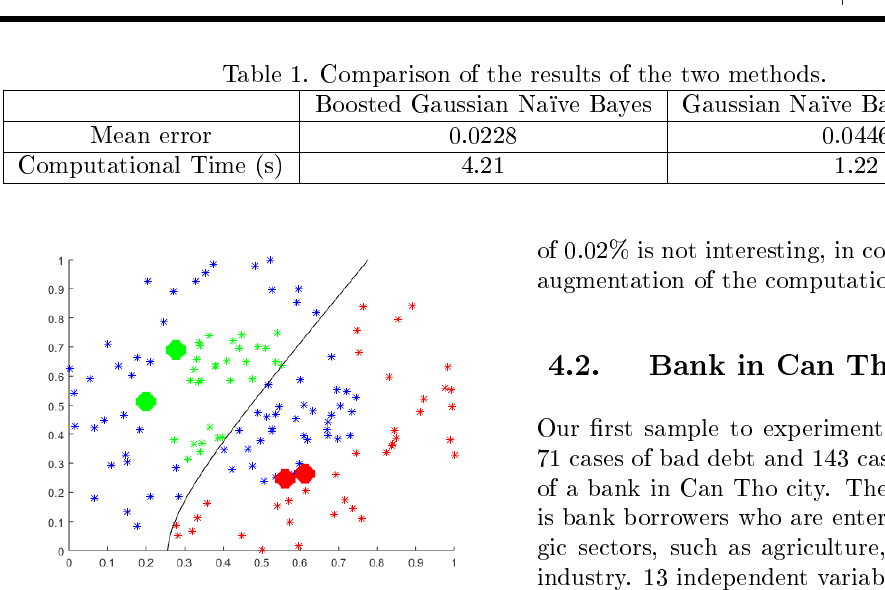
After 25 iterations of Boosted Gaussian Na(cid:239)ve Bayes versus the Gaussian Na(cid:239)ve Bayes. We ob- tain the (cid:28)nal mean error and the computational time (see Table